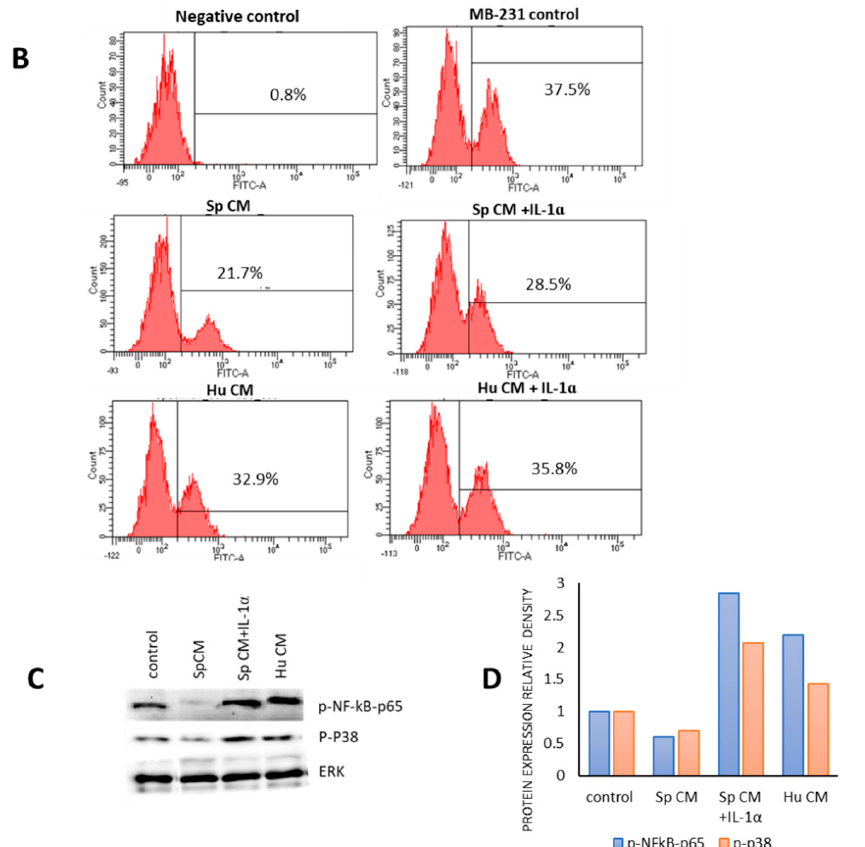
Figure 6. Spalax CM suppresses membrane-bound IL1- α and inhibits phosphorylation of NF- κ B and p38 in MDA-MB 231 cells. ( A ) Representative images showing MDA-MB231 untreated and treated with Spalax (Sp) and human (Hum) CMs. A magnified view of the enclosed regions is shown on a low panel, highlighting the differences in IL1- α distribution within the cells between treated with human and Spalax CMs for 24 h and untreated. Treated/untreated cells were stained with IL1 α –FITC and NF- κ B-p65 antibodies; nuclei were counterstained with DAPI. Arrows indicate the presence of IL1- α on the membrane ( B ) Representative images of flow cytometry showing differences in IL1 α surface membrane in MDA-MB-231 untreated, treated with Spalax CM, human CM, with or without recombinant human IL-1 α protein. ( C ) Representative western blot analysis demonstrating the phosphorylation of p65 (Ser536), p38 in MDA-MB231 treated with recombinant IL-1 α , Spalax CM (SpCM), Spalax CM+IL-1 α (SpCM+IL-1 α ), and human CM (Hu CM). ( D ) Densitometry quantification of western blots. Western blots and densitometries of additional biological repeats (MDA-MB-231 treated with Spalax CMs generated from fibroblasts of different Spalax individuals) are presented in Figure S4.